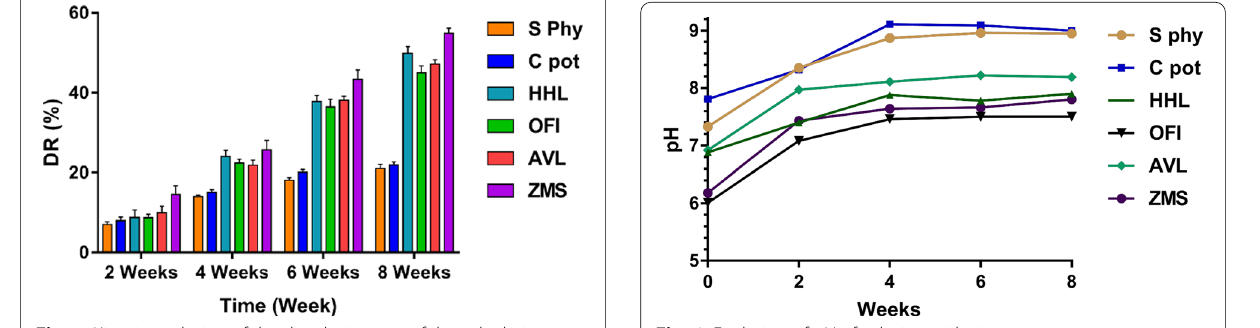
Fig. 5 Kinetic evolution of the dissolution rate of the calculations Fig. 6 Evolution of pH of solution with